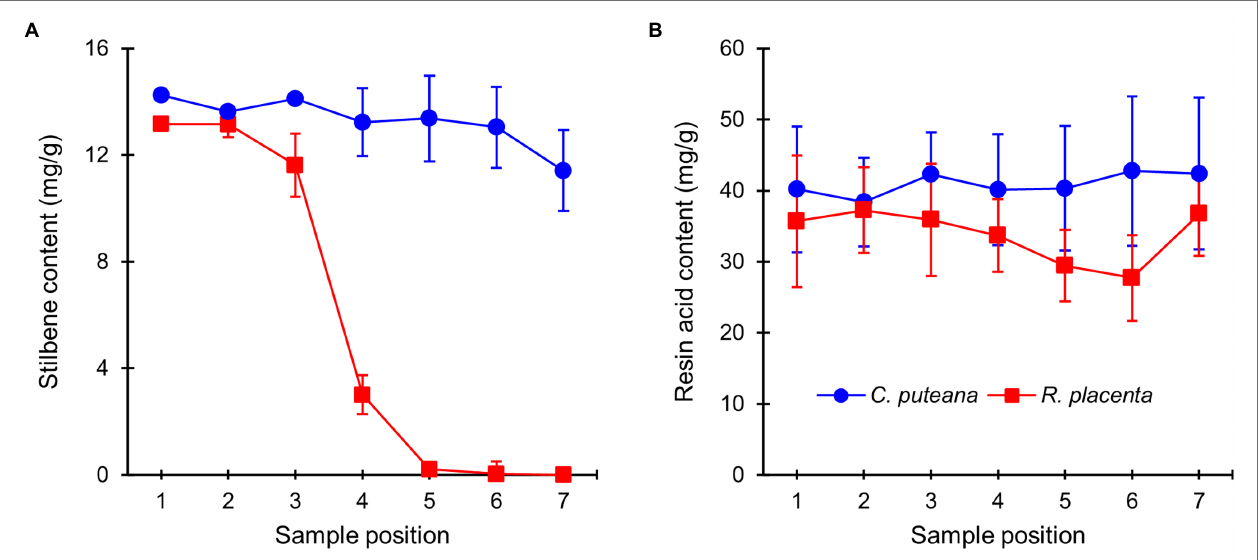
FIGURE 3 | Average contents (mg/g) of initial undegraded stilbenes (A) and resin acids (B) in heartwood blocks exposed to C. puteana and R. placenta . Error bars represent ±SD. N =